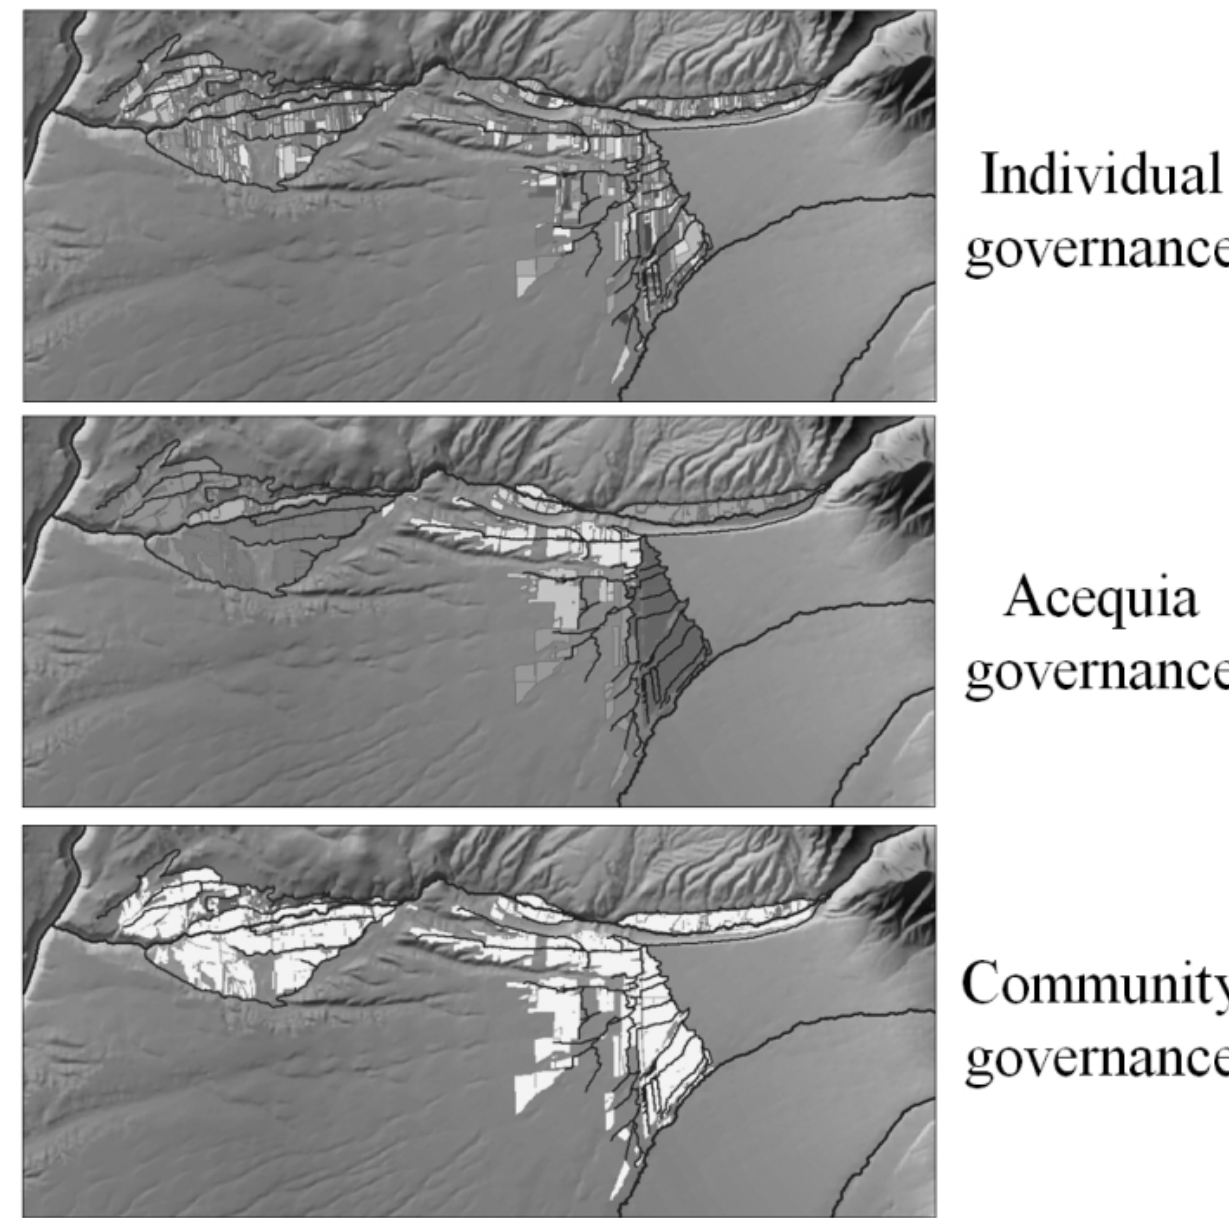
Fig. 7 . Spatial nesting of the acequia